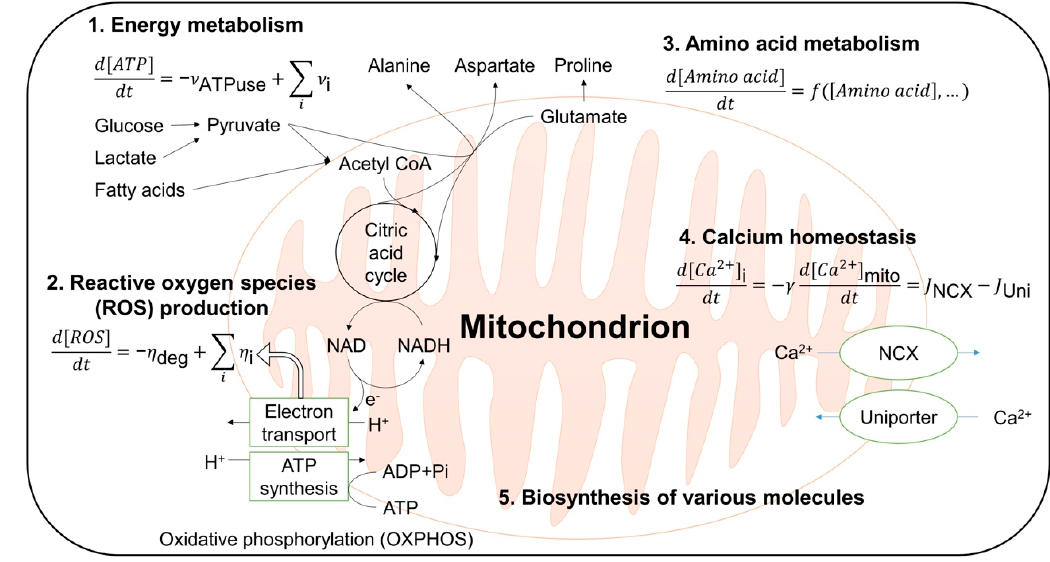
Figure 5. Computational modeling in a single mitochondrion scale. The major roles of a mitochondrion are illustrated schematically and example equations are displayed. [X] represents the concentration of the molecule X. ν ATPuse is the rate of ATP usage, ν i the ATP production rate of i -th pathway, η deg the rate of ROS degradation, η i the ROS production rate of i -th pathway, γ the volume ratio of the mitochondrion to the cytoplasm, and J the flux of calcium ions through the channel in the subscript. f can be any function, usually polynomial function, of amino acid and other intermediates concentrations. NCX refers to the sodium–calcium exchanger.